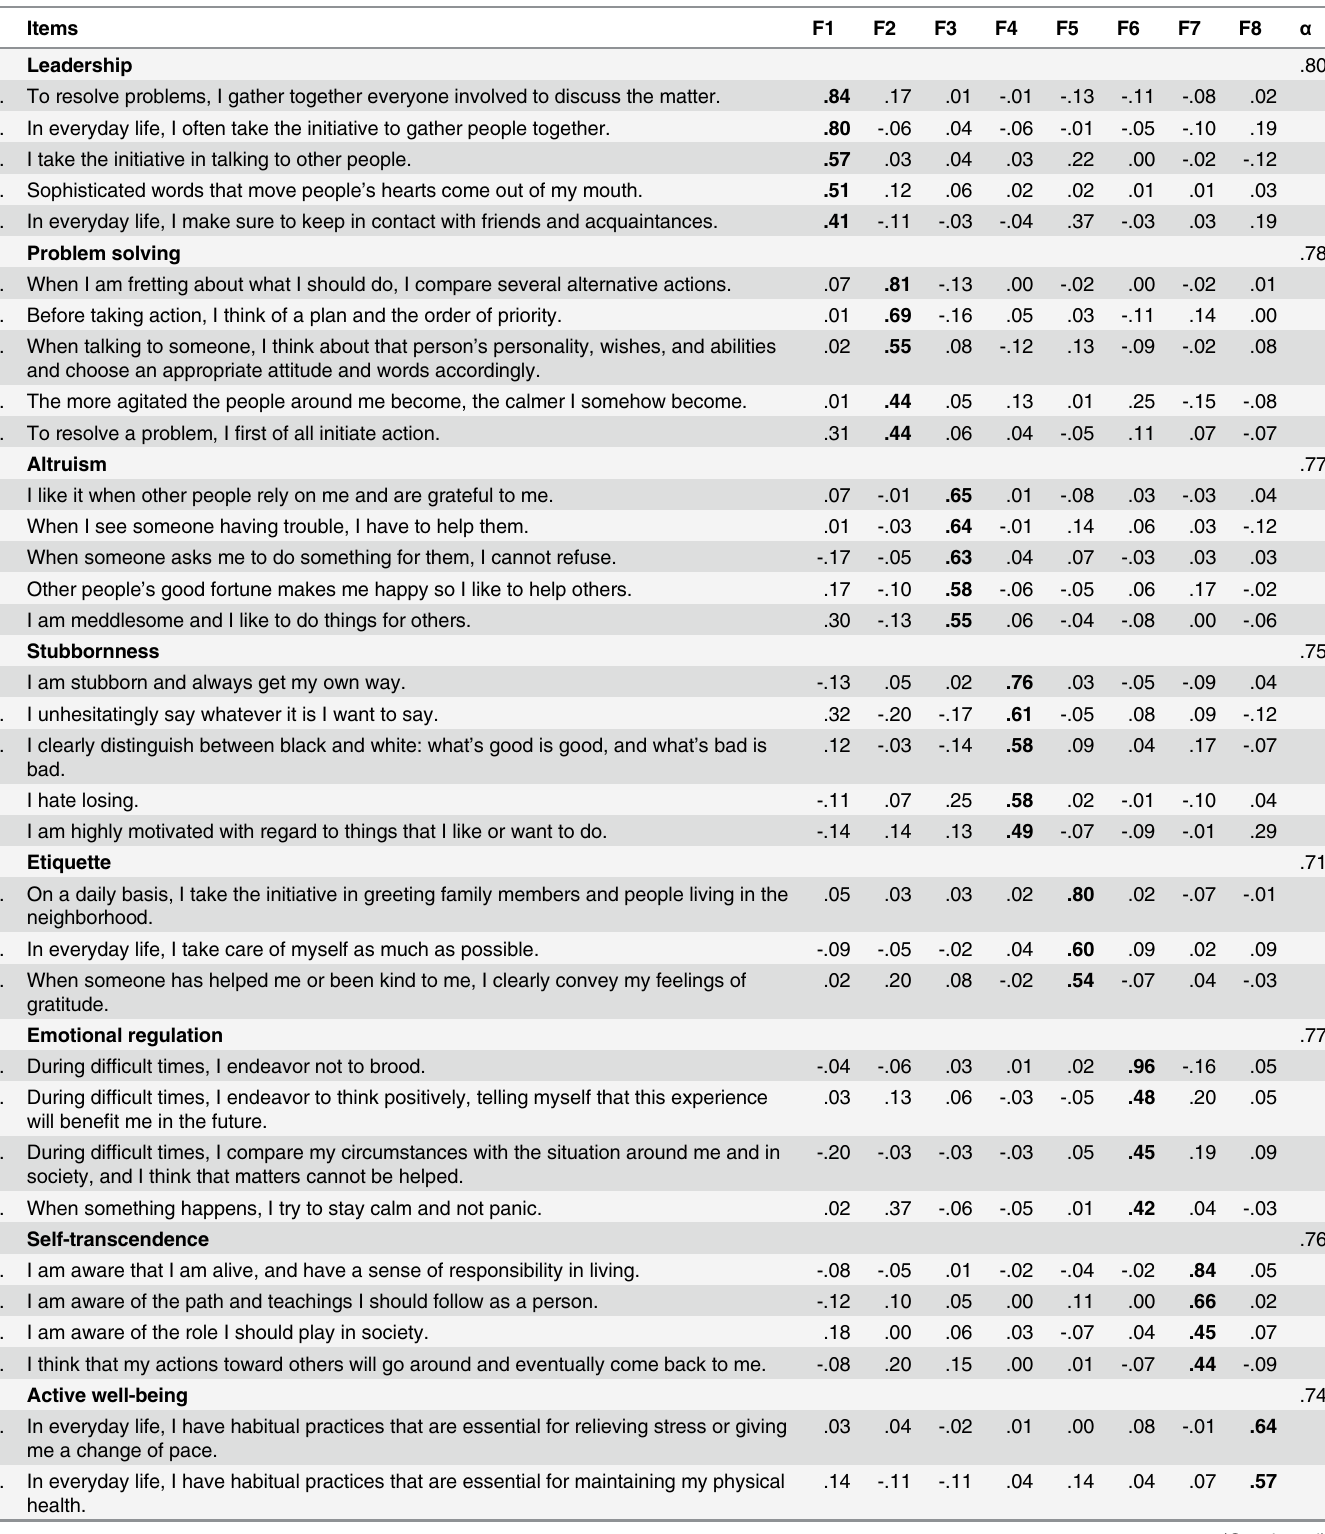
Table 2. Factor analysis of the power to live.